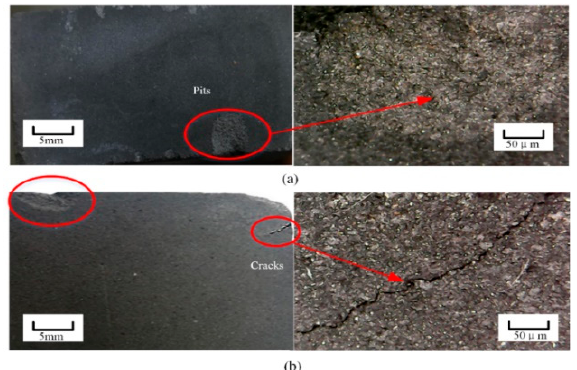
Figure 6. The surface morphology of the pantograph strip after repeated thermal shock.